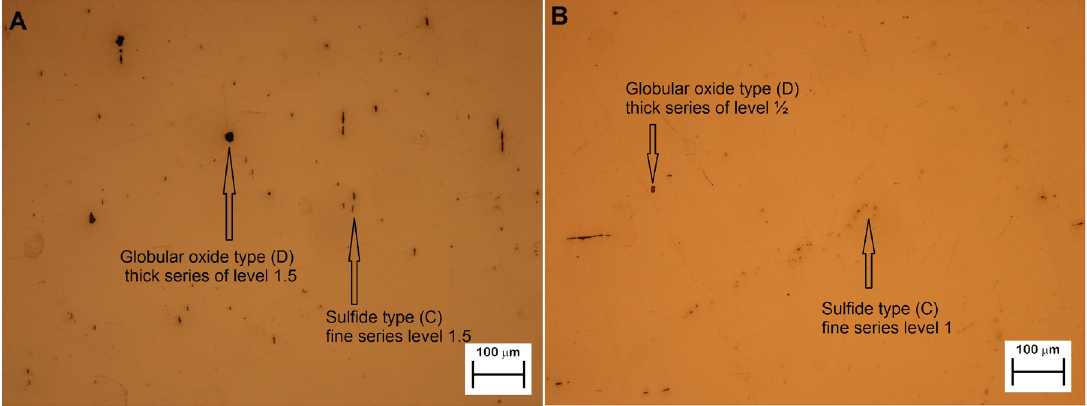
Figure 5. Optical images of unetched cross-sectional surfaces of the X20CrMo13 type steel blades. (A) Inclusions of the globular oxide type (D) thick series of level 1.5, and sulfide type (C) fine series level 1.5, at the fracture surface of the P2 (B) Inclusions of the globular oxide type (D) thick series of level ½, and sulfide type (C) fine series level 1, at a region of the VB blade base.